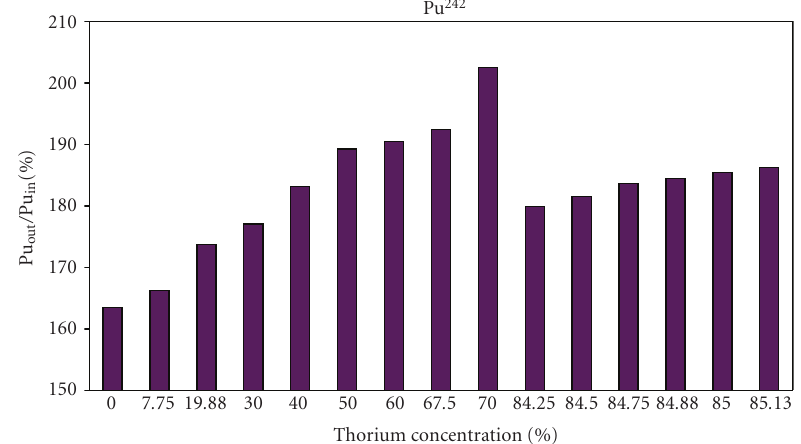
Figure 18: Pu 242 out /Pu 242 in versus Th concentration.